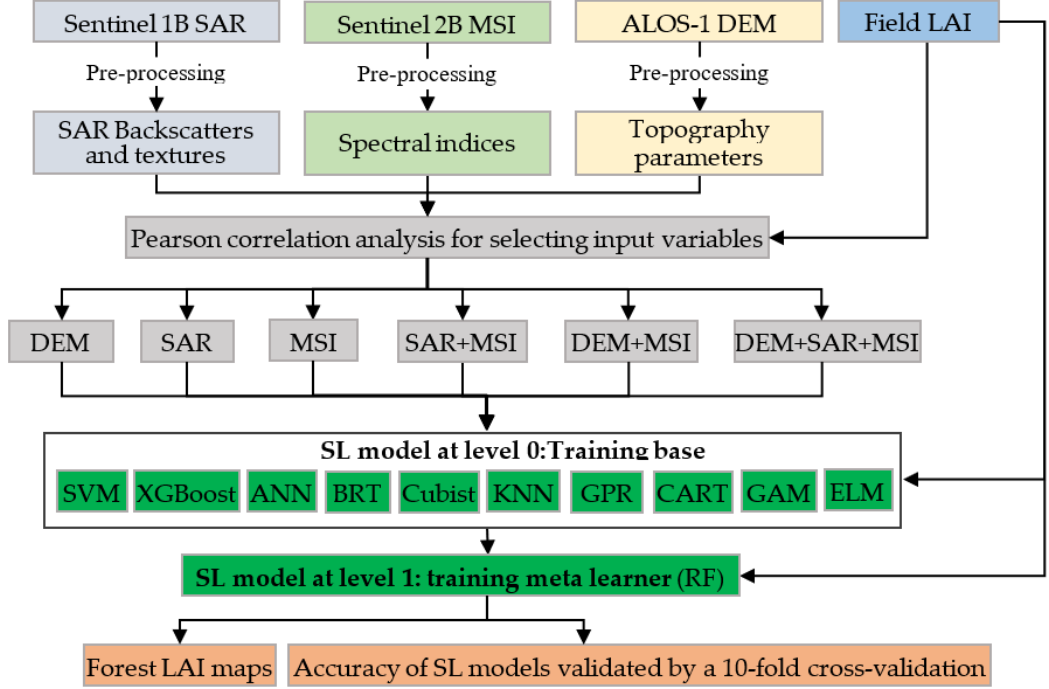
Figure 3. Workflow for mapping LAI using SAR, MSI, and DEM imagery and stacking learning.